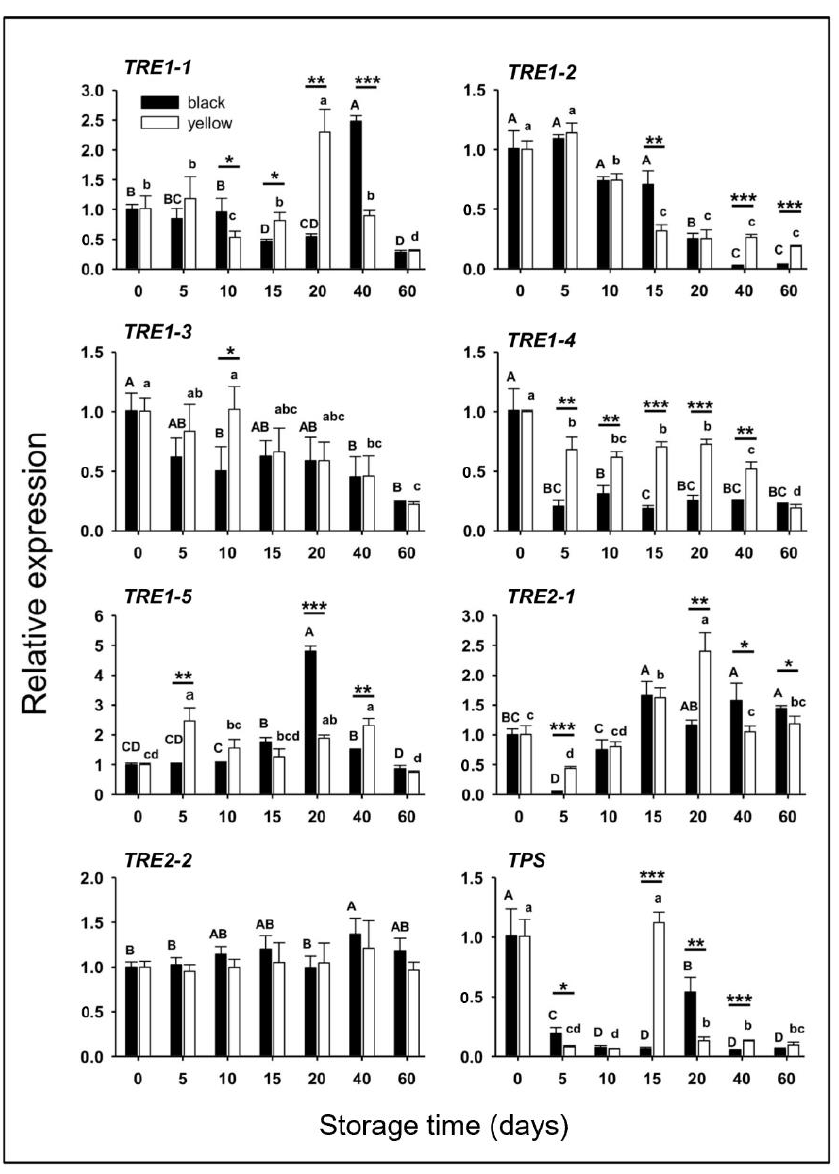
Figure 4. Changes in mRNA expression levels of seven trehalase genes and one TPS gene in H. axyridis yellow (non-melanic) and black (melanic) adults of the overwinter population during cold storage (0–60 days). The relative expression levels of the target genes were calculated using the Harp49 ( H. axyridis ribosomal protein 49 gene) expression level with RT-qPCR. Bars represent the mean (+SD) of three replicates. The expression level of each gene at 0 d of cold storage was used as the control group. Bars with different letters indicate significant differences (one-way ANOVA, p ≤ 0.05). Asterisks indicate significant differences between yellow and black adults in the same storage period ( t -test, *** p ≤ 0.001; ** p ≤ 0.01; * p ≤ 0.05).